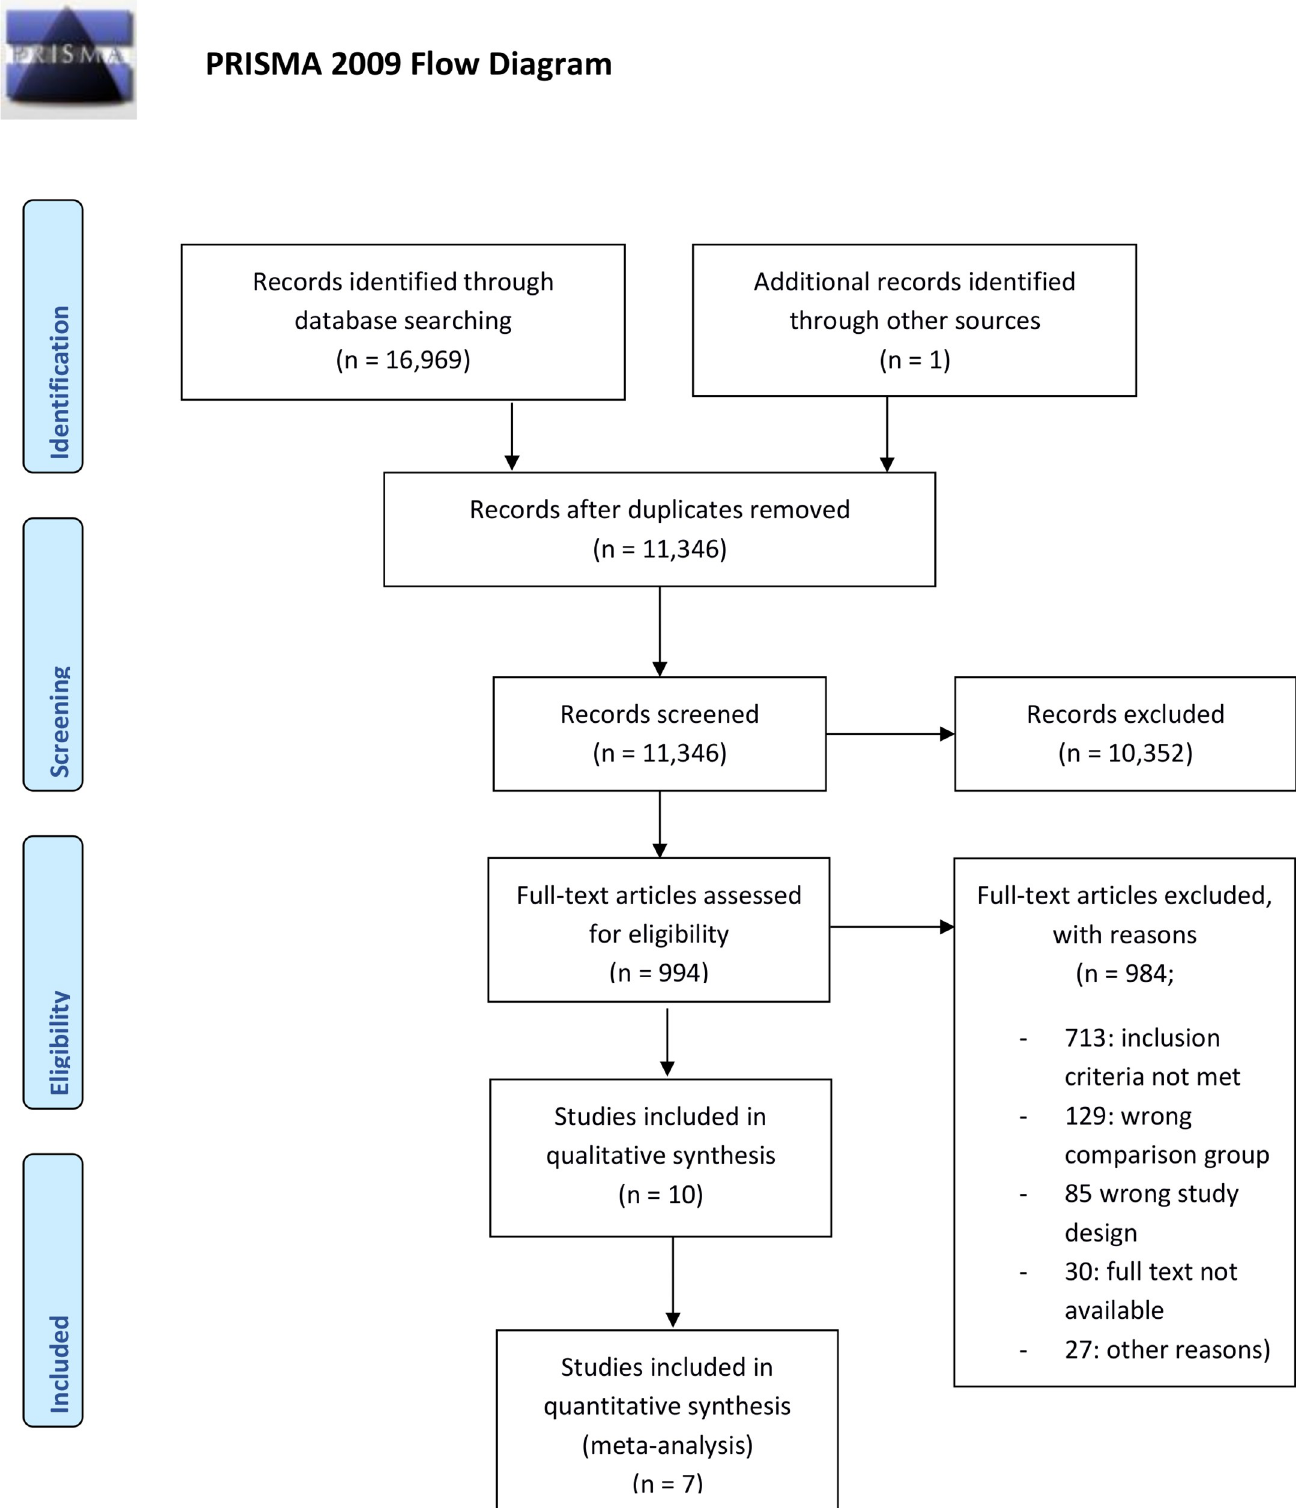
Fig 1. PRISMA flow chart. Presenting the search for relevant studies.